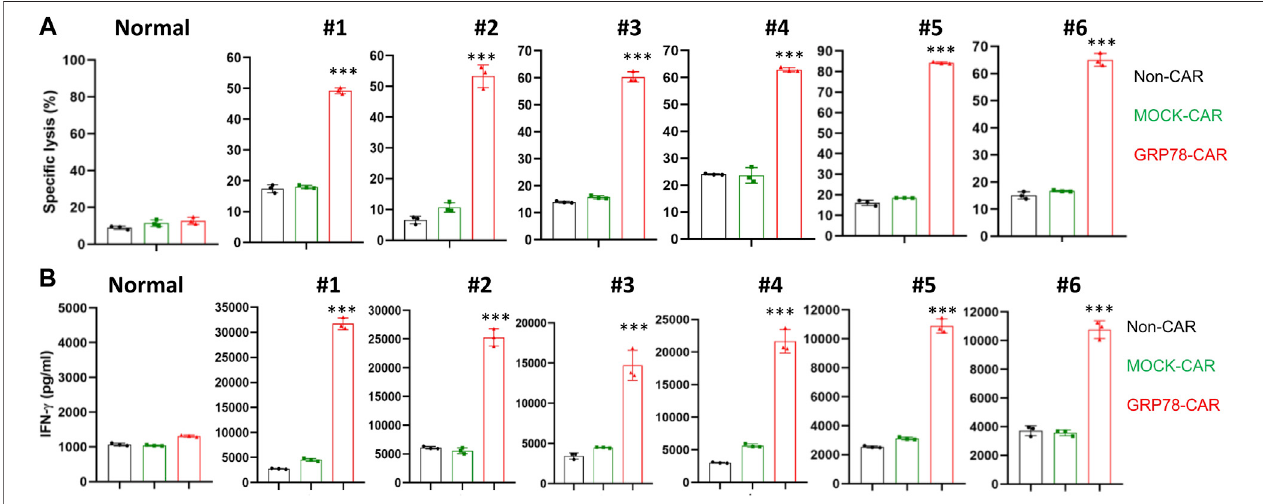
FIGURE 3 | Glucose-regulated protein 78 (GRP78) – chimeric antigen receptor (CAR) T cells eradicate primary acute myeloid leukemia (AML) blasts. (A) cytotoxic assaymeasuringthespeci fi clysisoftargetcells.CFSE-labeledprimaryAMLpatientPBMCwereco-incubatedwithNon-CART,MOCK-CART,andGRP78-CARTcells ataneffector/targetratioof5:1for48 h.ThenormalPBMCsamplewascollectedfromthebloodofthehealthydonors.Experimentswererepeatedwithatleasttriplicate samples. Data represent means ± SDs. GRP78-CAR vs . Non-CAR, MOCK-CAR, and CD19-CAR. *** p < 0.01 (two-sided Student ’ s t-test). (B) ELISA measurementofcytokineinterferon(IFN)gammainthecellsupernatantwasdeterminedfollowing48-hincubationofprimaryPBMCcellswithspeci fi edCARTcells.Two sideStudent ’ st-testwasperformedbetweenGRP78-CARTcelltreatmentswithNon-CARandMOCK-CAR.Datarepresentmeans±SDs.GRP78-CARvs . Non-CAR, MOCK-CAR, CD19-CAR. *** p < 0.01 (two-sided Student ’ s t-test).